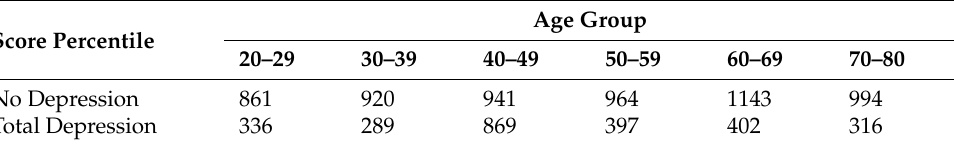
Table 6. Depression by age